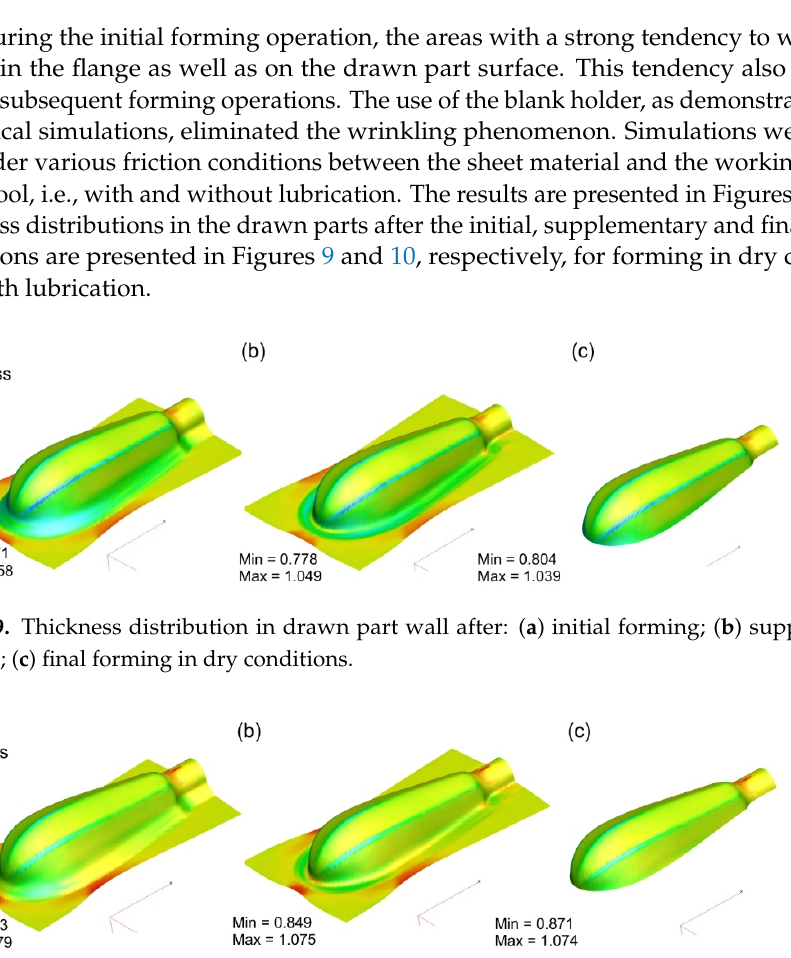
Figure 10. Thickness distribution in drawn part wall after: ( a ) initial forming; ( b ) supplementary forming; ( c ) final forming performed with lubricant.